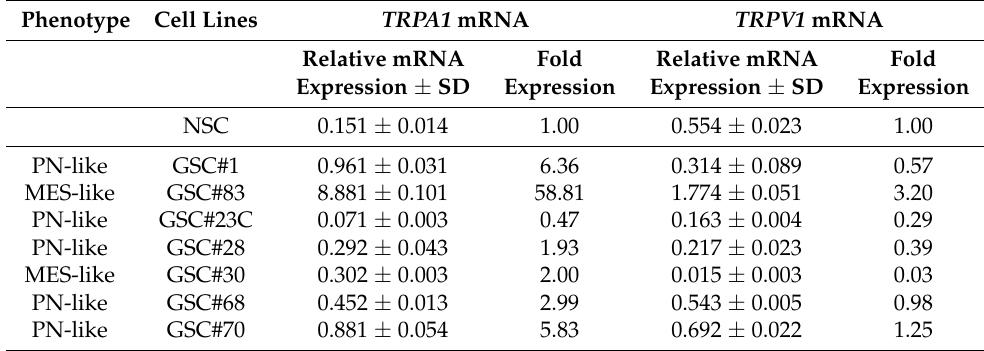
Table 2. TRPA1 and TRPV1 channels mRNA expression in